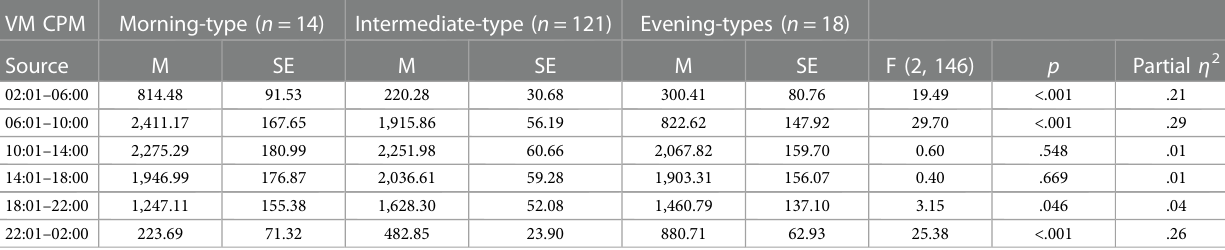
TABLE 3 Chronotype group differences in total activity within six 4-hour intervals ( N